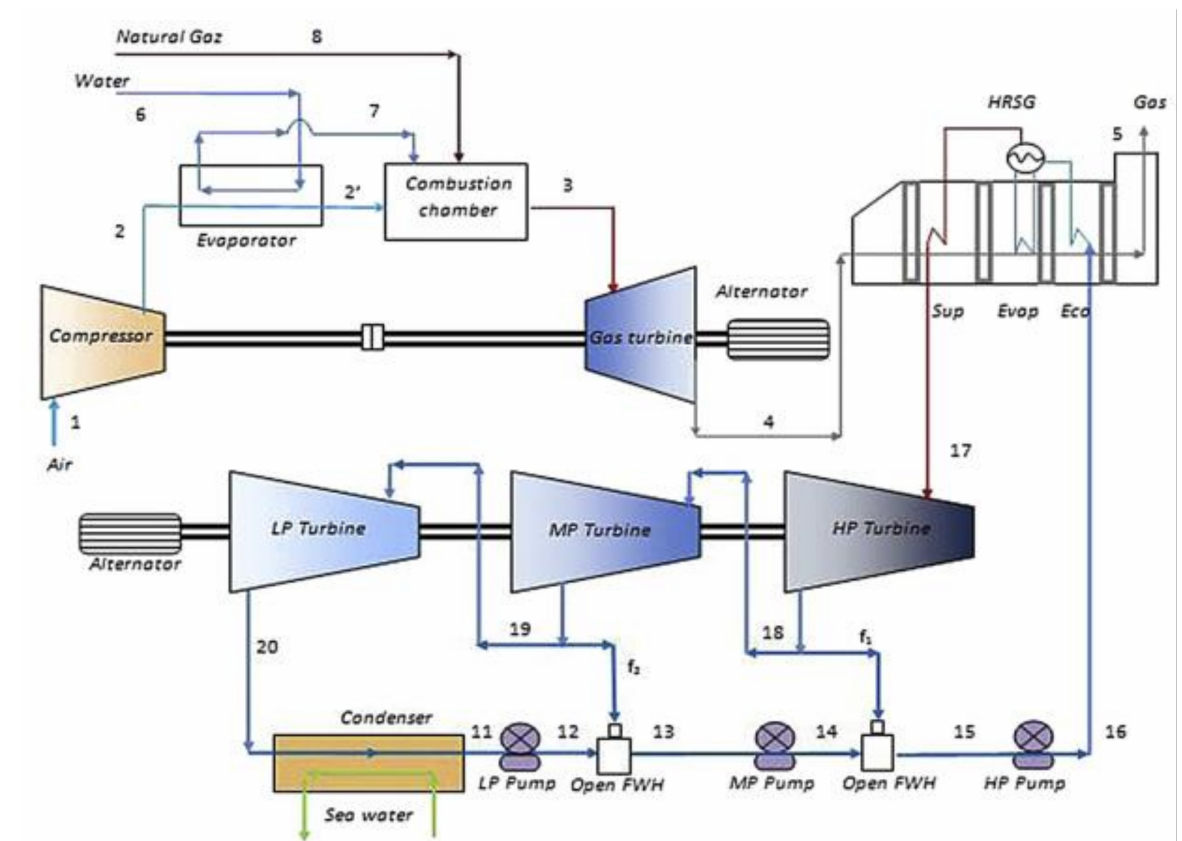
Figure 1. The simple layout of CCPP (reprinted with permission from Elsevier 2017